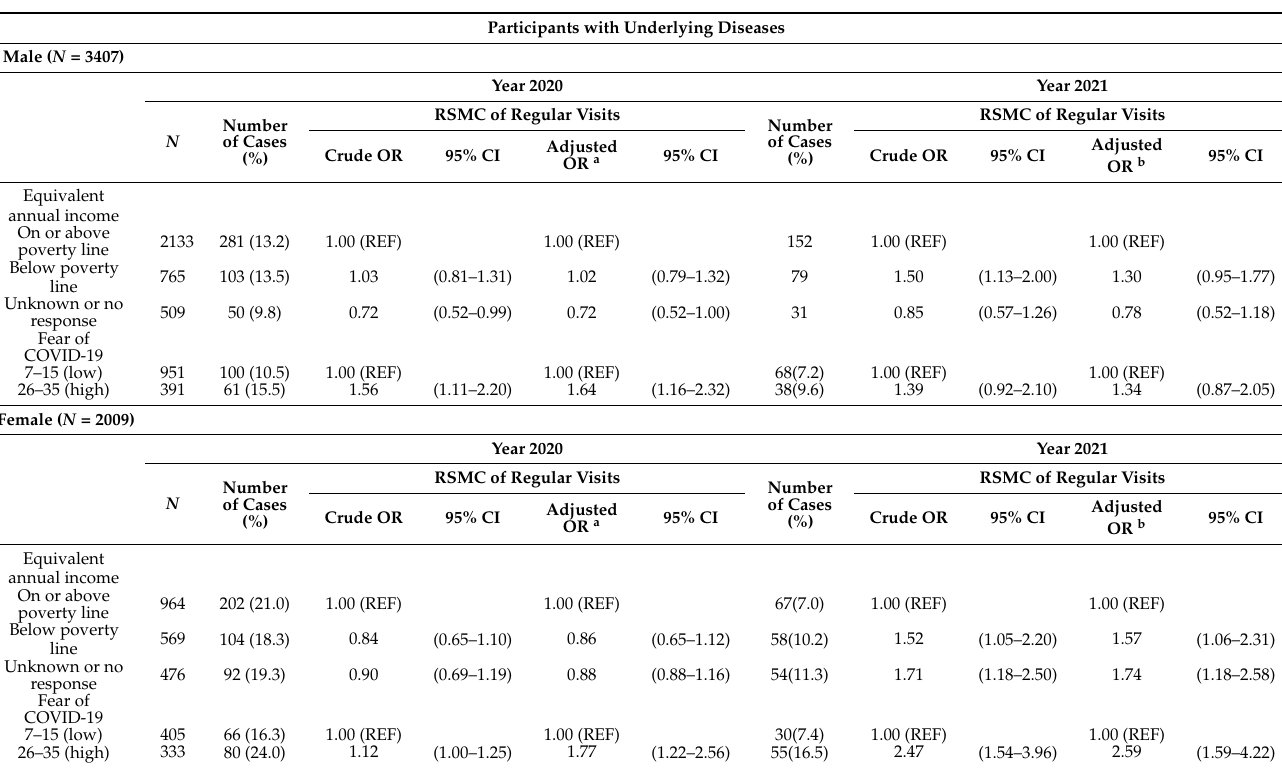
Table A2. Odds ratios (ORs) of household income for refraining from seeking medical care (RSMC) of regular visits among participants with underlying